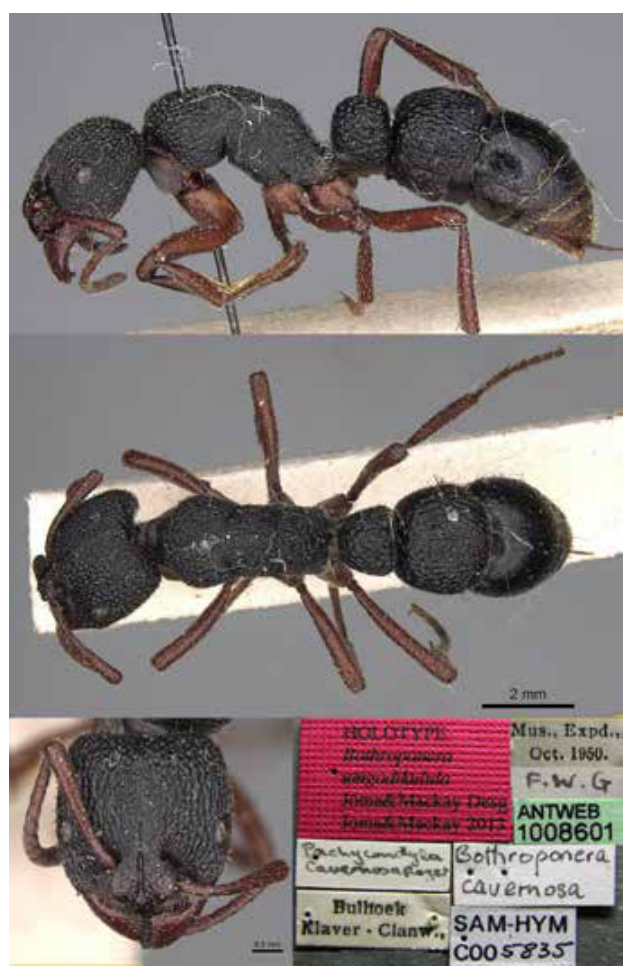
Plate 10 : Bothroponera. umgodikulula , holotype worker. (Photo by Michele Esposito/From www.antweb.org. Accessed 23 February